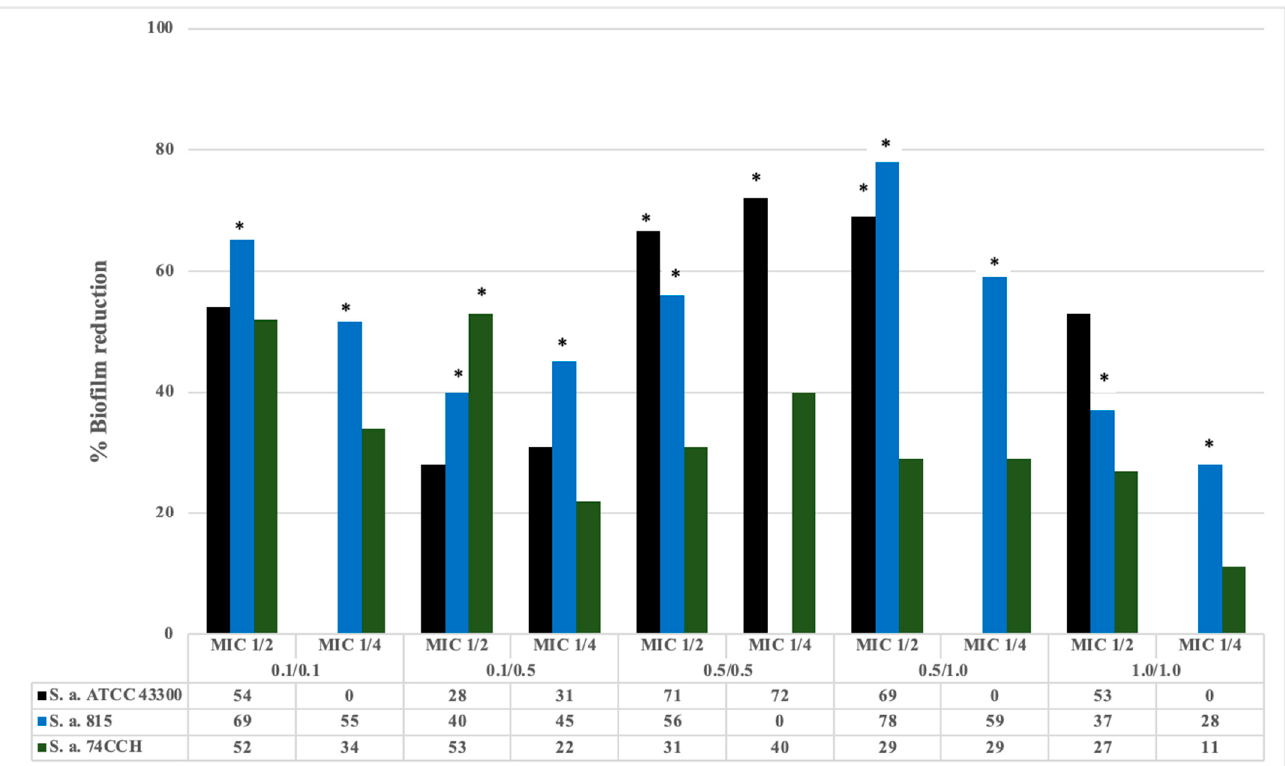
Figure 3. The e ff ect of methanol extracts obtained from the biomass of R. montana bioreactor cultures grown on LS medium variant supplemented with di ff erent concentrations of NAA/BAP mg/L (0.1/0.1, 0.1/0.5, 0.5/0.5, 0.5/1.0, 1.0/1.0), 5-week growth cycle, on S. aureus strains bio fi lm formation reduction. The reduction percentage of bio fi lm formation was calculated using the following formula: [(OD 492 nm with extract/OD 492 nm without extract) × 100]. Statistically signi fi cant di ff erences are indicated as * p < 0.05 vs. each control group.